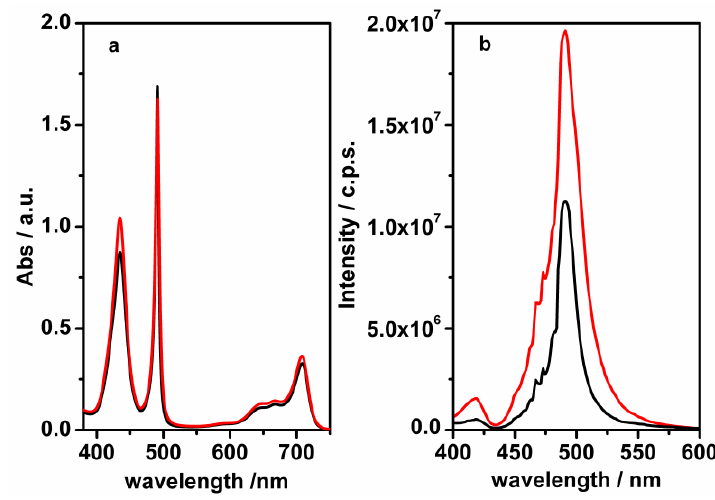
Figure 5. ( a ) UV-vis spectra; and, ( b ) RLS spectra of the solutions of the J-aggregates template on L-Lys 2 mM (black curves represent the “acid first” procedure, and red curves represent the “acid last” procedure).